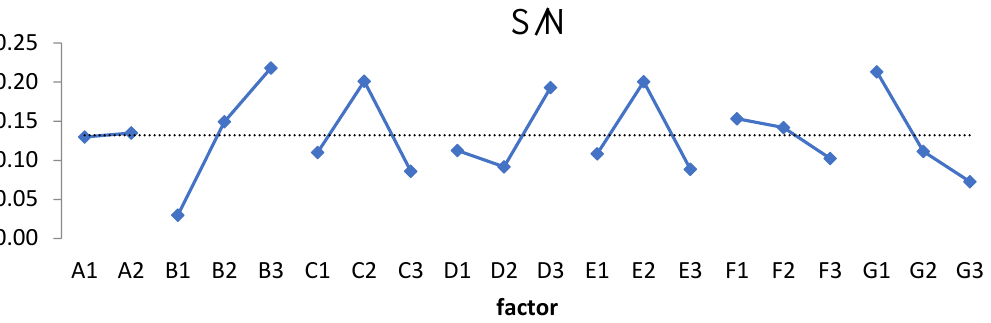
Figure 4. The fishbone plot of the S/N (cf. Equation (4)). The dominant factors become B (signal game), C (resolution vs. speed), D (dynamic range), E (XRES), and G (time gain compensation).